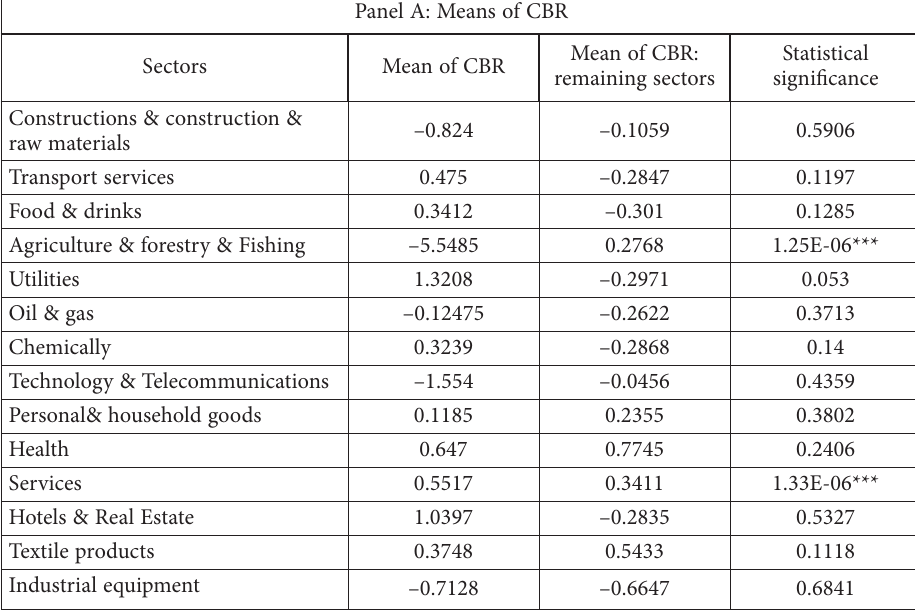
Table 6. Means of CBR, OCF to CL and OCF to TD of firms with limited flexibility in different